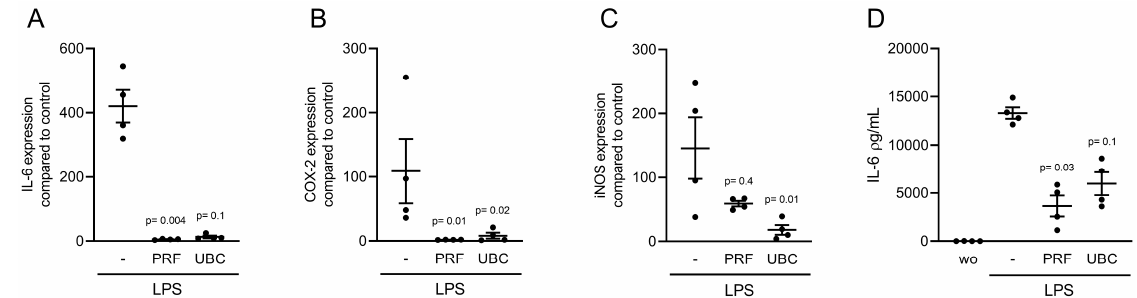
Figure 5. Lysate from PRF and UBC can reduce LPS-induced inflammation in RAW264.7 cells. RAW264.7 cells were exposed to 30% lysates extracted from PRF and UBC membranes in the presence of 100 ng/mL LPS. ( A – C ) The data show the x-fold changes in IL-6, COX-2 and iNOS gene expression ( D ) and IL-6 levels in the cell supernatant, n = 4. Statistical analysis was based on uncorrected Dunn’s tests, and p values are indicated compared to the LPS group. Significance was set at p < 0.05.